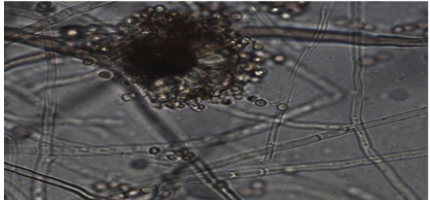
Figure 2: Wet mount preparation using lactophenol cotton blue was done and observed under light microscope. Presence of long and smooth conidiophores with black conidial heads was